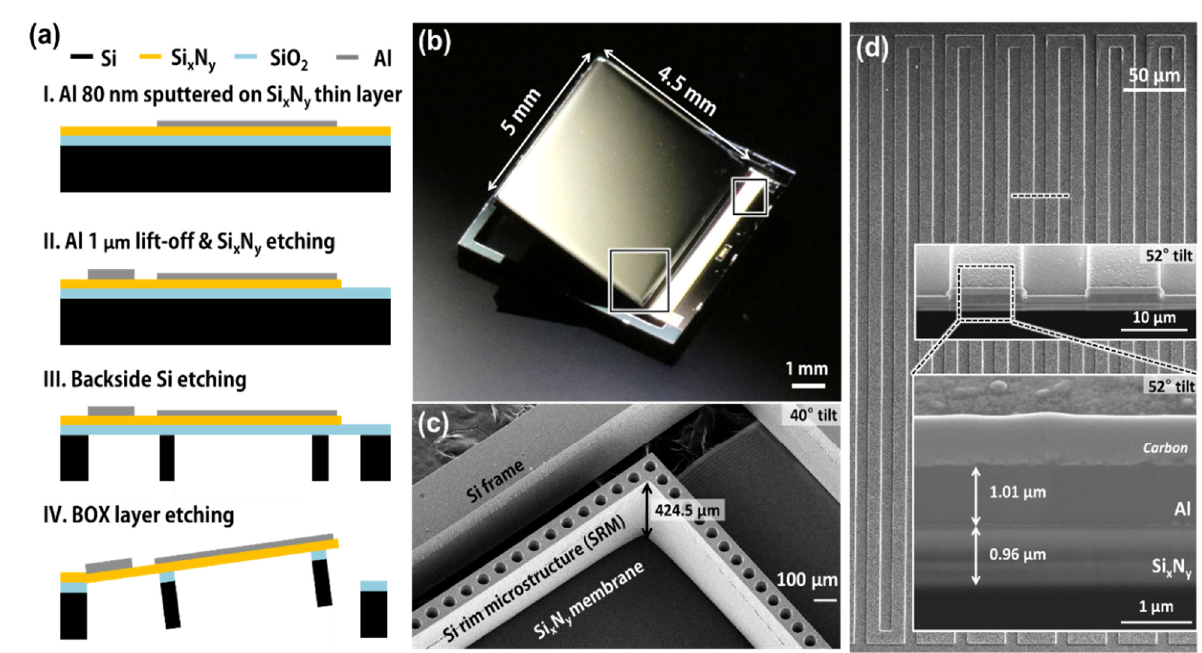
Figure 3. Microfabrication of SRM-mirror. ( a ) Microfabrication procedures including ( I ) Al mirror sputtering, ( II ) lift-off of Al Joule heater, ( III ) backside DRIE of silicon, and ( IV ) isotropic etching of thermal oxide layer. ( b ) Optical image of the SRM-mirror. ( c ) Tilted SEM image of SRM-mirror and the attached SRM (backside view). ( d ) SEM image of Al Joule heater. Insets depict a cross-sectional view of bimorph structures comprising of the Al Joule heater and silicon nitride membrane.